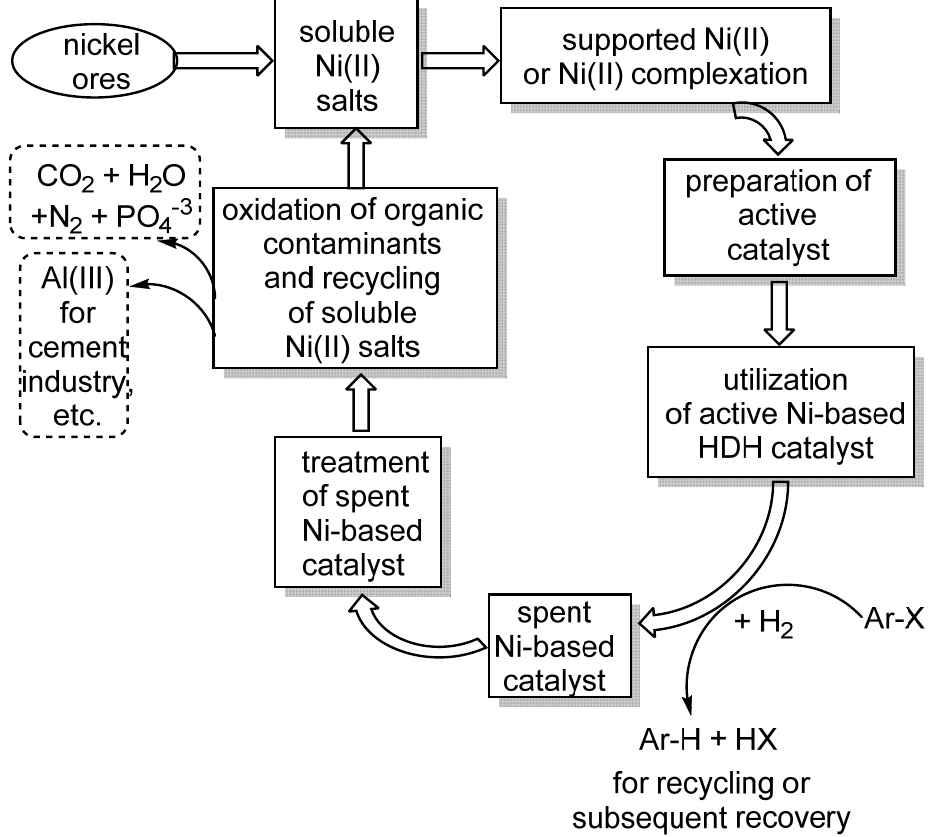
Scheme 26. Applying the principle of circular economy in Ni-catalyzed HDH